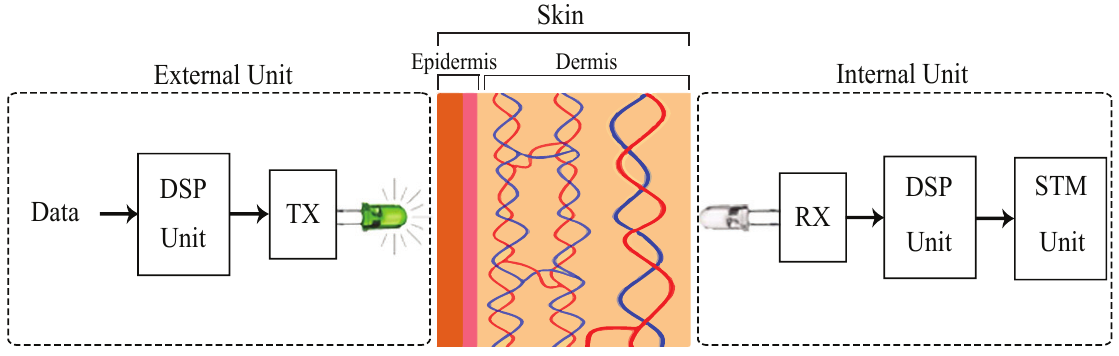
Figure 1. System model under